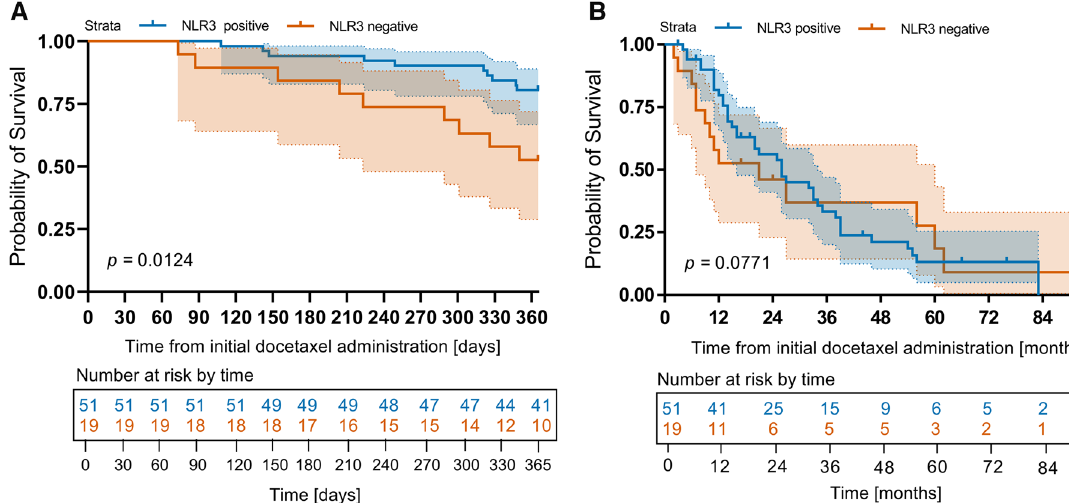
Fig. 3 Kaplan–Meier analysis of A 1-year survival and B overall survival depending on positive or negative NLR slope over 3 (NLR3) cycles. NLR neutrophile-to-lymphocyte ratio, NLR3 NLR slope over the first 3